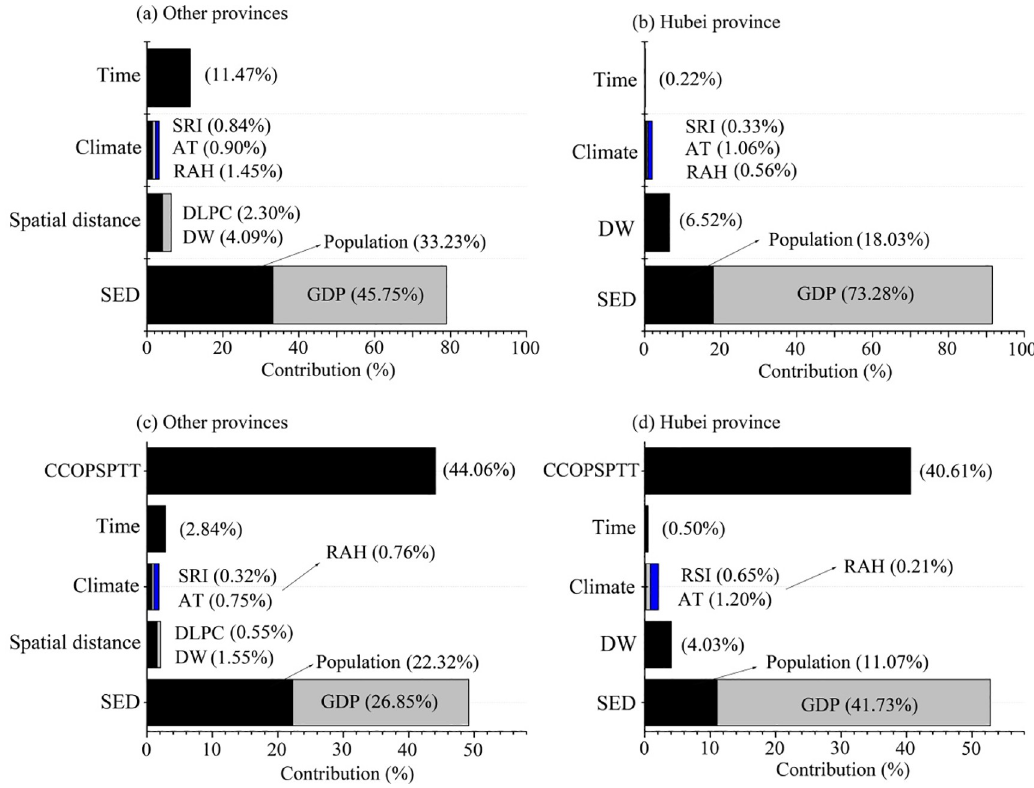
Fig 1. The relative contributions of different factors to the confirmed cases (a and b) and deaths (c and d) over population size per 100000 at every 5 consecutive days (CCOPSPTT and DOPSPTT). Instruction of DW and DLPC as suggested in Table 3. SED is socio-economic determinants. SRI, AT and PAH is solar radiation intensity, average temperature and relative air humidity,